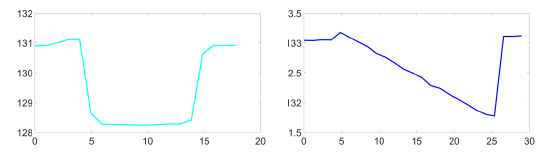
Figure 2. DSM profiles of areas with steep slopes: river (left), garage entrances (right).